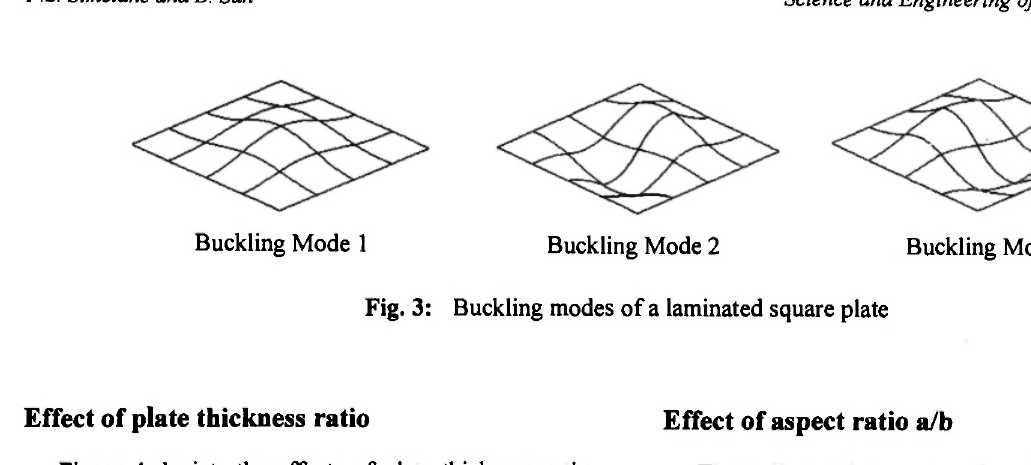
Fig. 3: Buckling modes of a laminated square plate